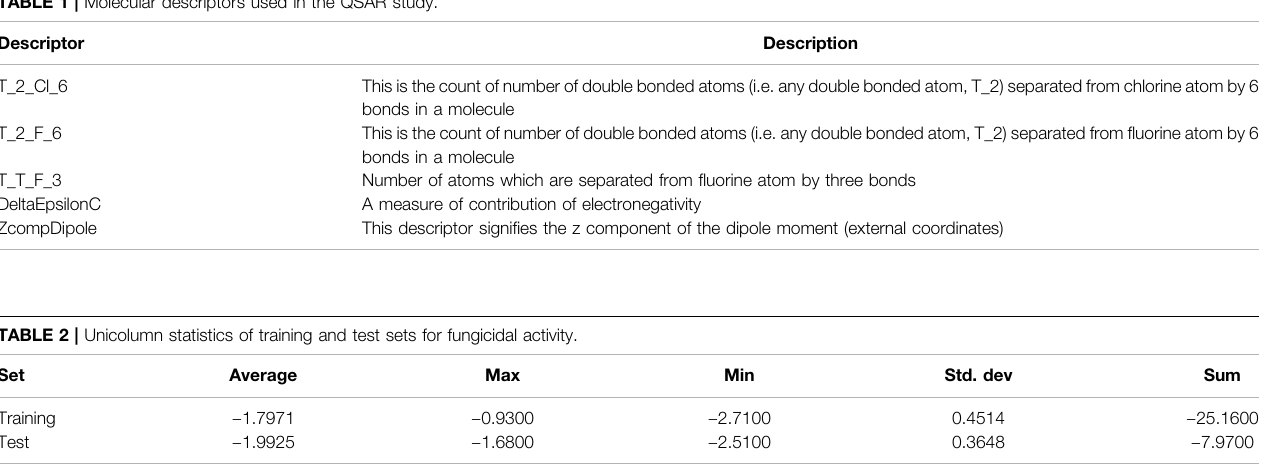
TABLE 1 | Molecular descriptors used in the QSAR study.